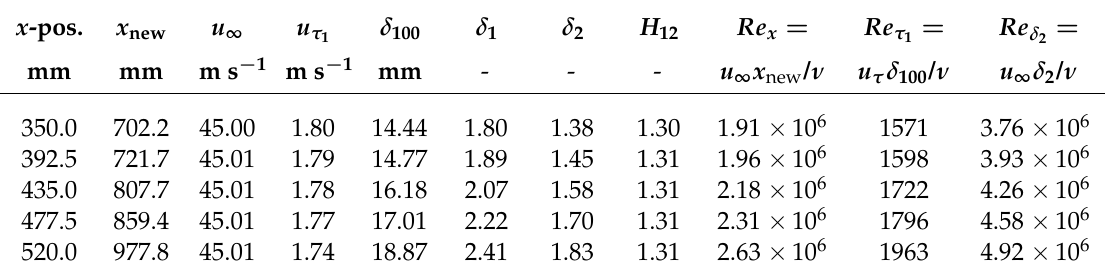
Table 1. Boundary layer parameters for the analytical approaches.